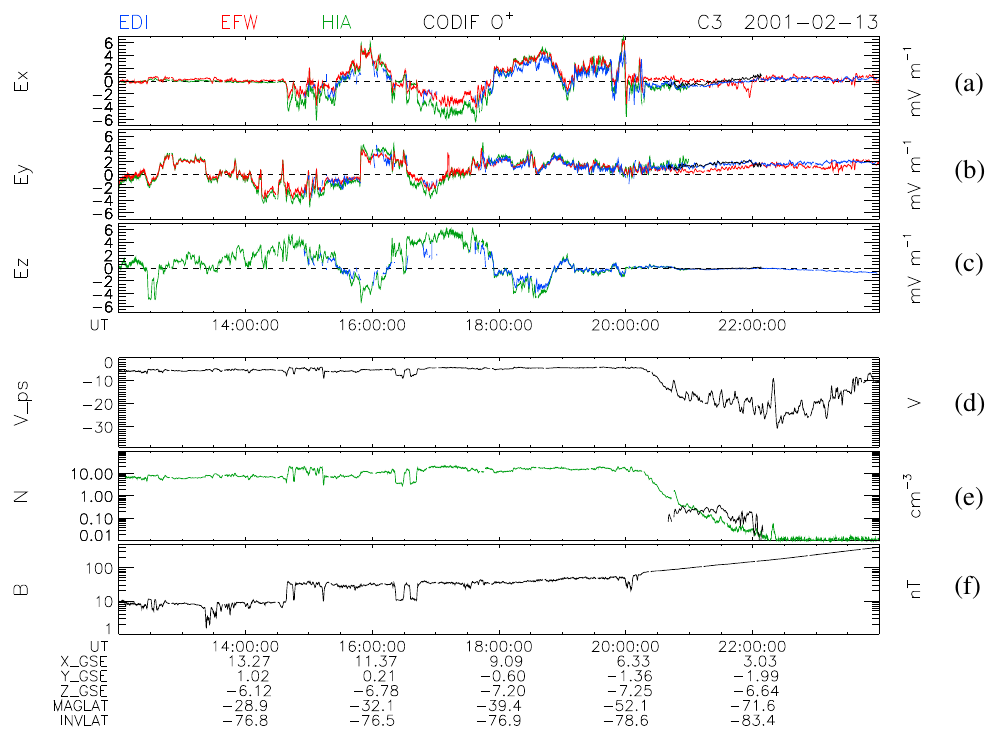
Fig. 4. Comparison of EFW and EDI data from the solar wind through the magnetosheath into the magnetosphere. Panels from top to bottom: (a) E x in DSI coordinates (almost GSE, see text) in an inertial frame. Red is EFW data based on spin fits from probe pair 12, blue is EDI, black is the x component of − v × B from CIS HIA velocity moment and FGM magnetic field, green is the same for CIS CODIF O + data. (b, c) E y and E z in same format. (d) EFW probe-to-spacecraft potential V ps ≈− V sc . (e) Density moments from CIS: HIA (green, assuming protons only) and CODIF O + (black). (f) FGM magnetic field magnitude.